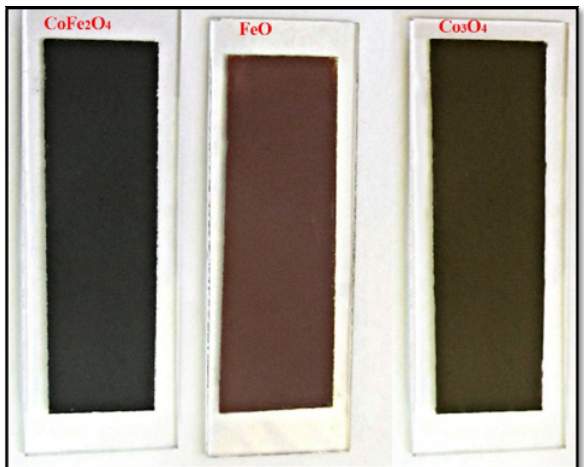
Fig. 2. Glass slides coated with paste of cobalt ferrite, Iron oxide and cobalt oxide nanoparticles prepared by wet chemical route using Dr Blade method.